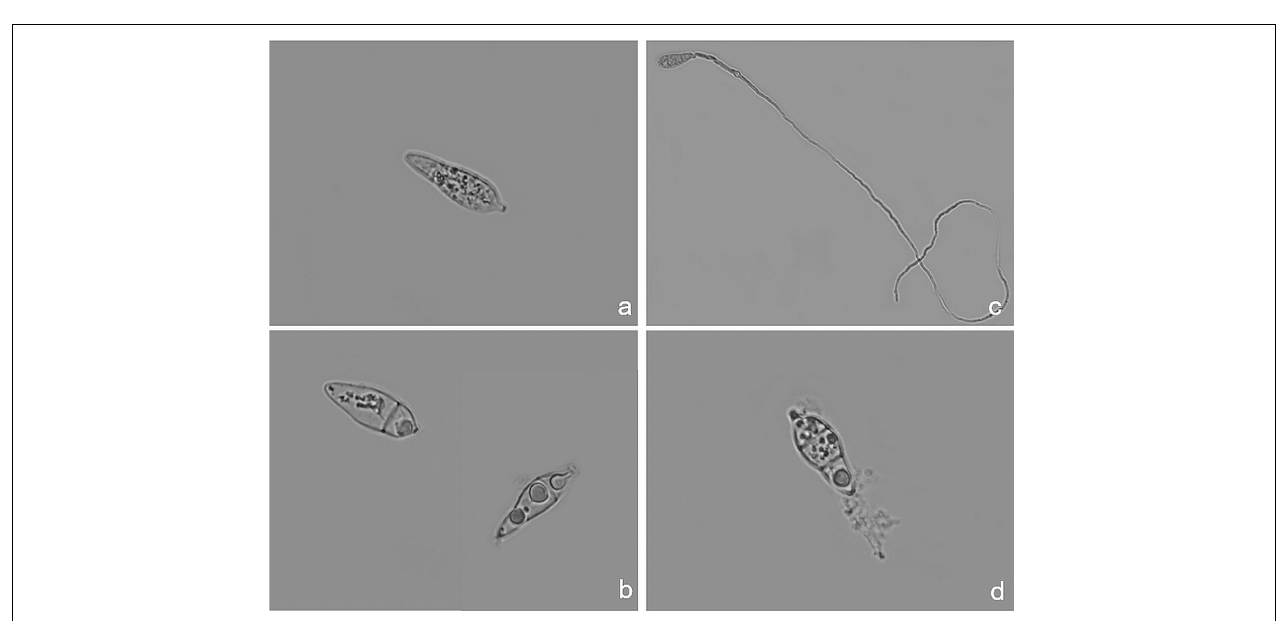
FIGURE 3 | Data represent the mean Disease Severity Index (DSI) evaluated on rice (cv. Vialone Nano) at 8 days post inoculation (dpi) with spores of Pyricularia oryzae IT10 strain and are the mean of at least three independent biological replicates. Standard errors were indicated by error bars. Significant reduction ( p < 0.05) in disease severity was observed with all peptides except Pep 22Rink. Pep 3 was used as a negative control, being ineffective against P. oryzae . Data were statistically analyzed by applying the one way-Anova Bonferroni–Holm test (different lowercase letters indicate significant differences at p < 0.01, different uppercase letters indicate significant differences at p < 0.05).